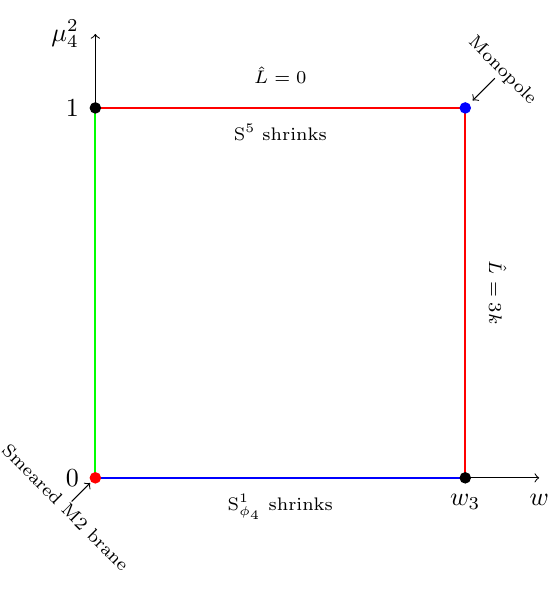
× S 1 is fibered. The blue line z φ 4